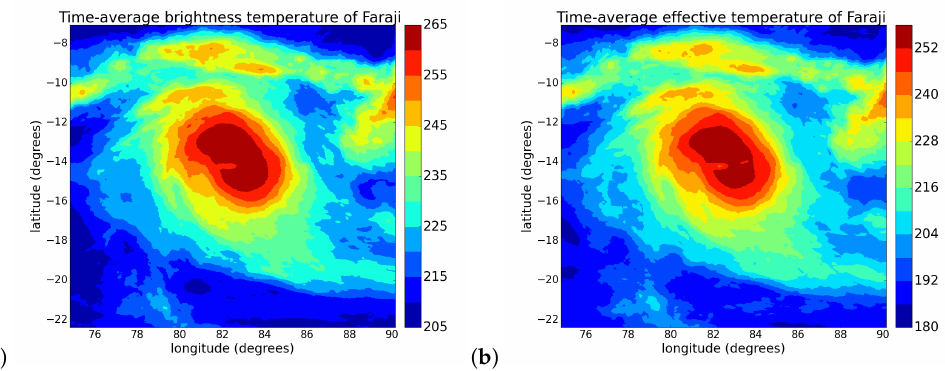
Figure 5. Comparison between the brightness temperature T b ( a ) and the effective temperature T ef f ( b ) of the Faraji